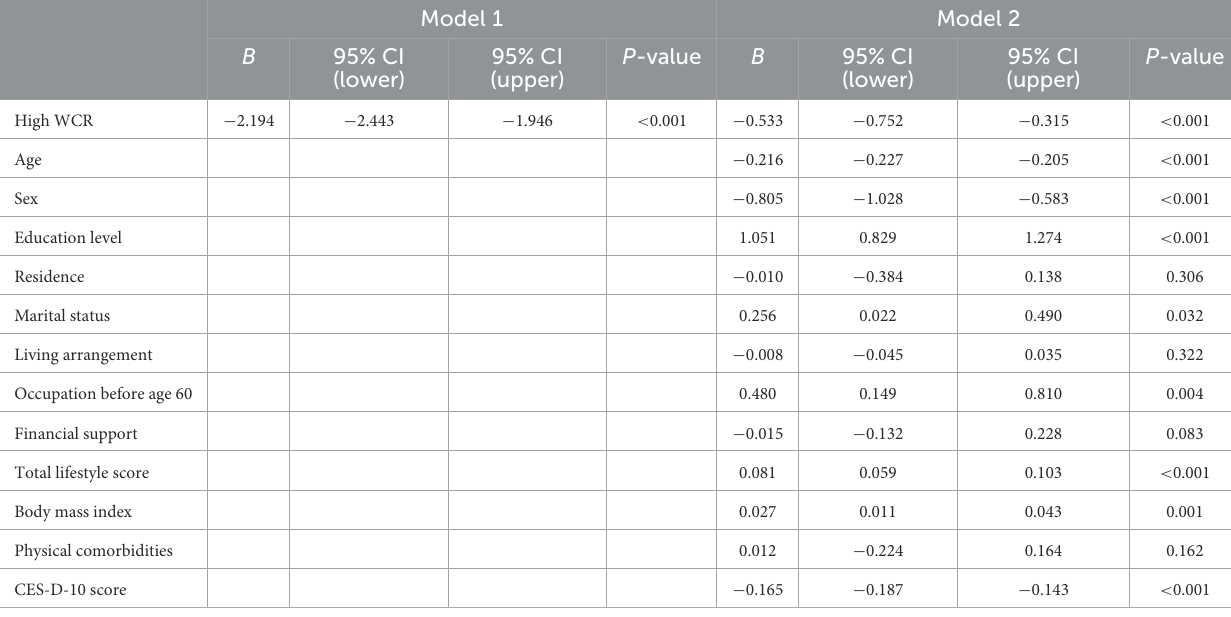
TABLE 2 The association between waist-to-calf circumstance ratio (WCR) and cognitive function. Model 1